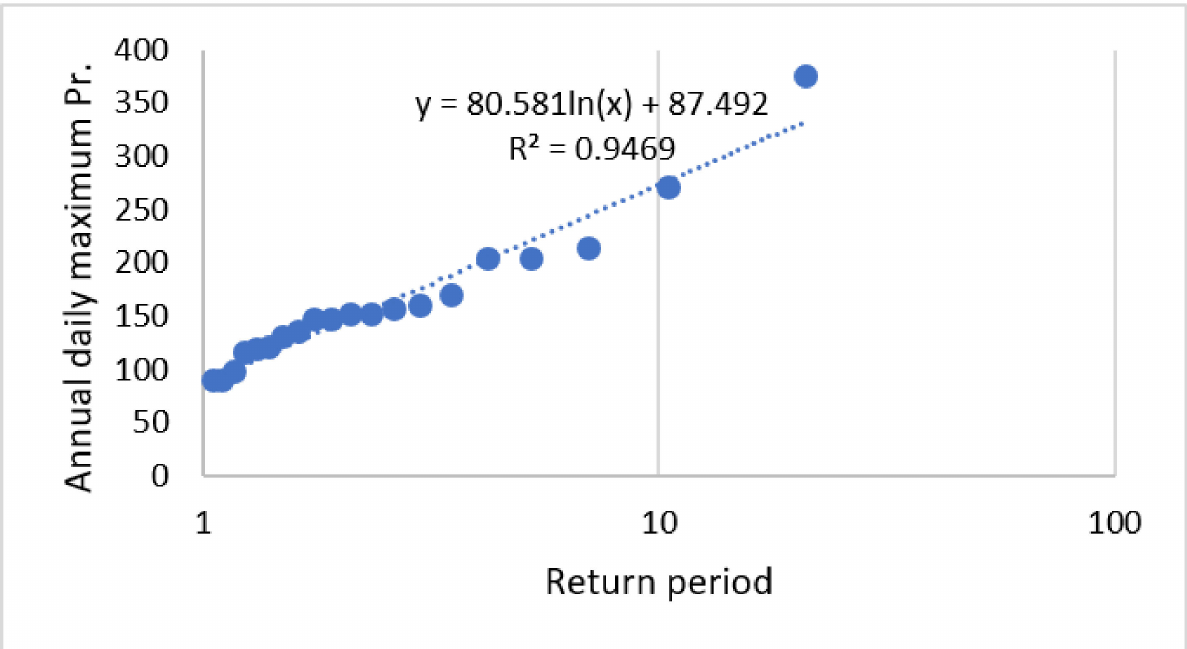
Figure 6. Logarithmic equation for the BCC-CSM2-MR model in the base year. With reference to the base period, all the stations showed a 11.86%, 11.99%, 12.07%, 12.15%, and 12.19% increase in 5-, 10-, 20-, 50-, and 100-year precipitation, respectively, in the near future. Similarly, a 10.64% and 3.94% increase in the next 5 and 10 years in the far future, respectively, was shown, as well as a 0.49%, 4.47%, and 6.63% decrease in the next 20, 50, and 100 years, from the BCC-CSM2-MR model (see Figure 7A). From the MRI-ESM2-0 model, the results were quite different, in that 5-, 10-, 20-, 50-, and 100-year annual maximum precipitation increased by 28.96%, 41.17%, 50.68%, 60.44%, and 66.31%, respectively, in the near future. Increases in 5, 10, 20, 50, and 100 years in the far future are 50.54%, 52.97%, 54.87%, 56.81%, and 57.99%, which are slightly less than the near-future precipitation for the 100-year return period (see Figure